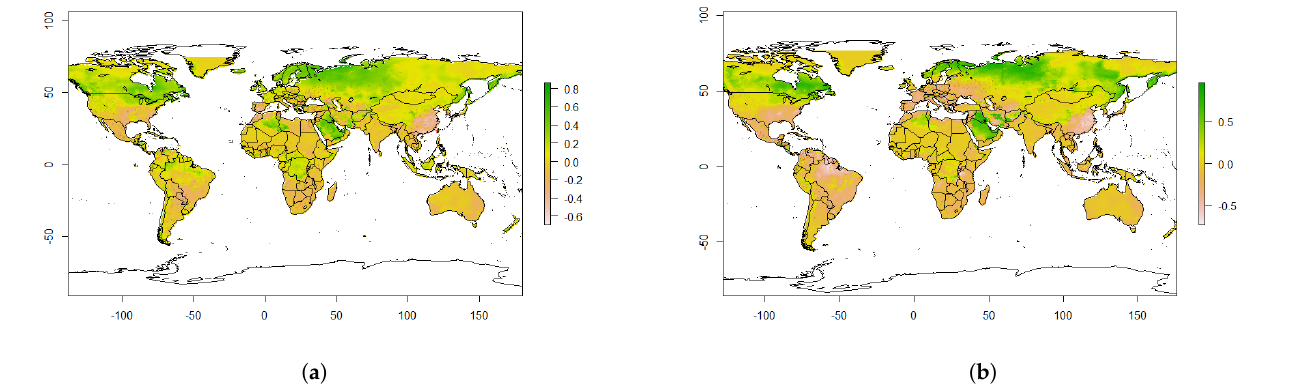
Figure 4. Changes in habitat suitability for ( a ) BTB and ( b )